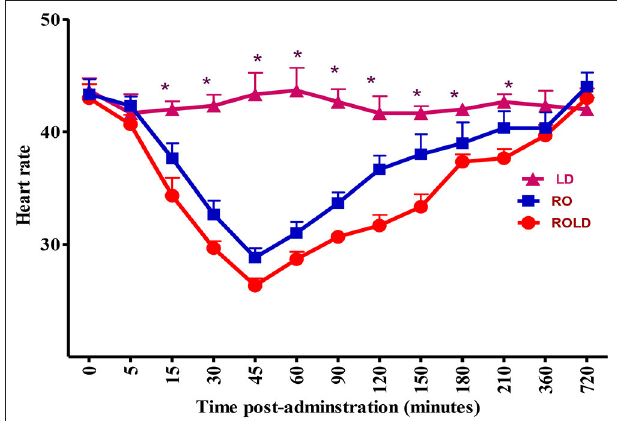
FIGURE 3 | Heart rate (beat/min; mean ± SE) pre-epidural and post-epidural injection of romifidine (RO) (50 µ g/kg), romifidine-lidocaine (ROLD) (50 µ g and 0.3 mg/kg) and lidocaine (LD) (0.3 mg/kg) in camels ( n = 18). *Significant at P < 0.05.